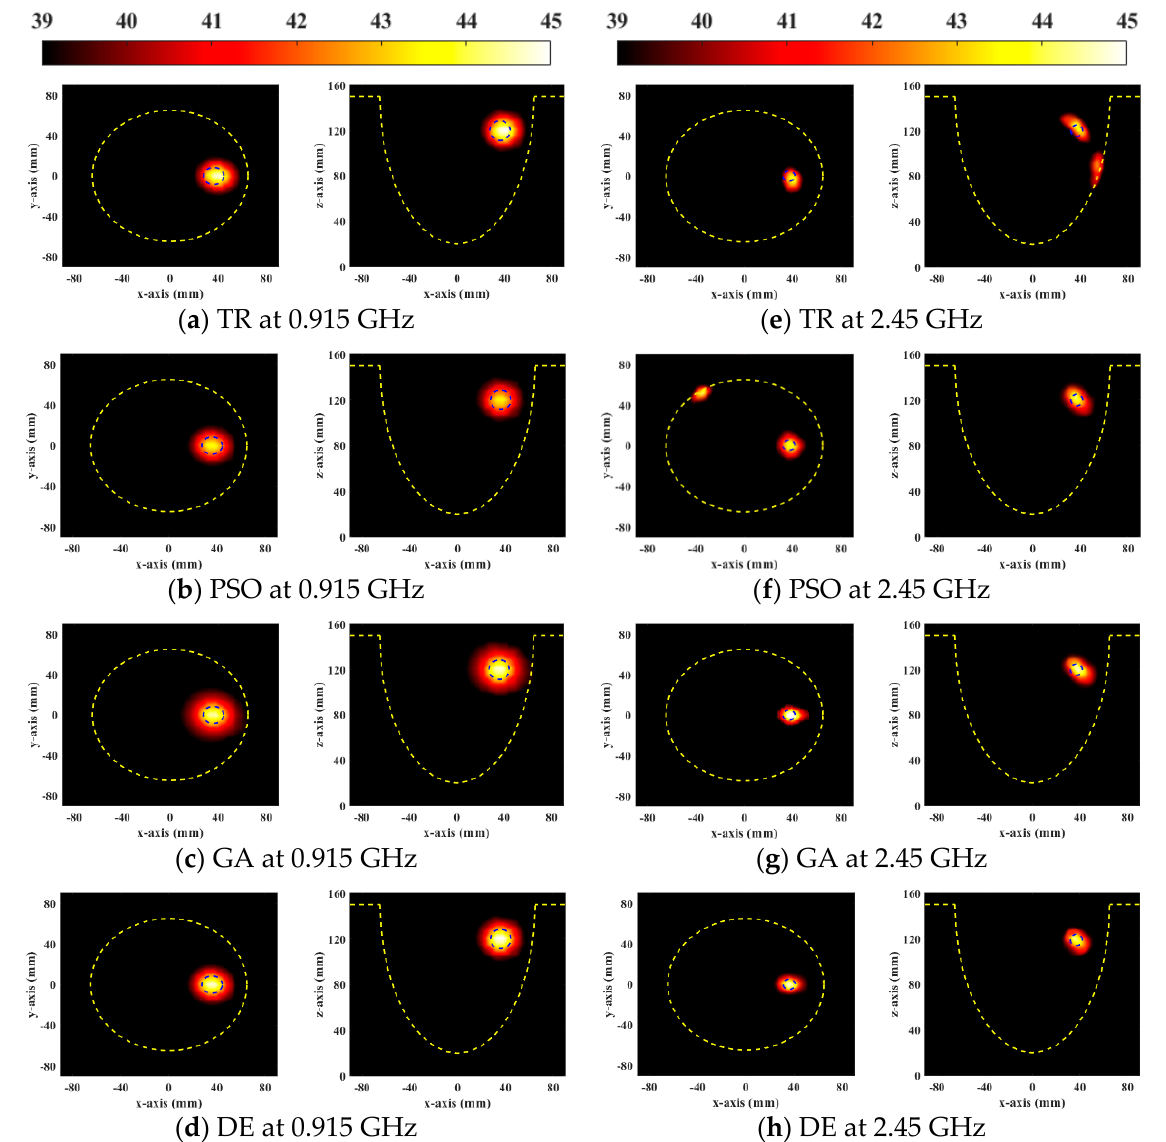
Figure 4. Steady-state temperature distribution in axial (XY) and coronal (XZ) planes of a general breast model treated by four FMHT optimization methods.